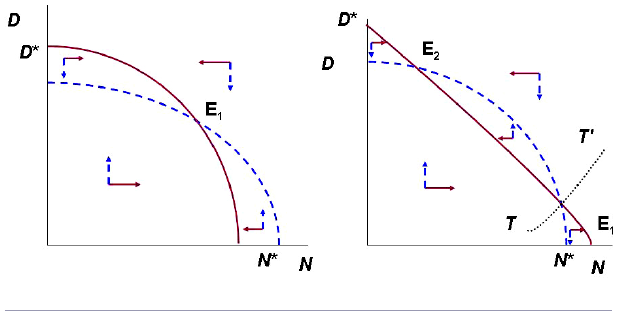
Fig. 9. More complex density-dependent models of interaction: wild herds in competition with domestic herds. Solid line shows stable population level for wild herds, given domestic herd size. Arrows show direction of movement for population levels not on the